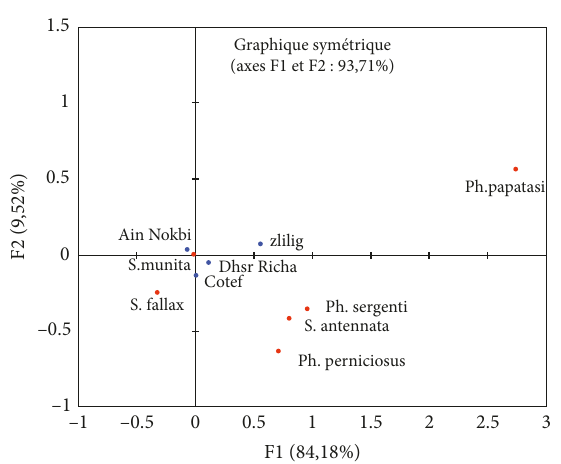
Figure 4: Axis factorial map (F1-F2, 93.71%) of the sand fly species inventoried in the six study stations (CFA).